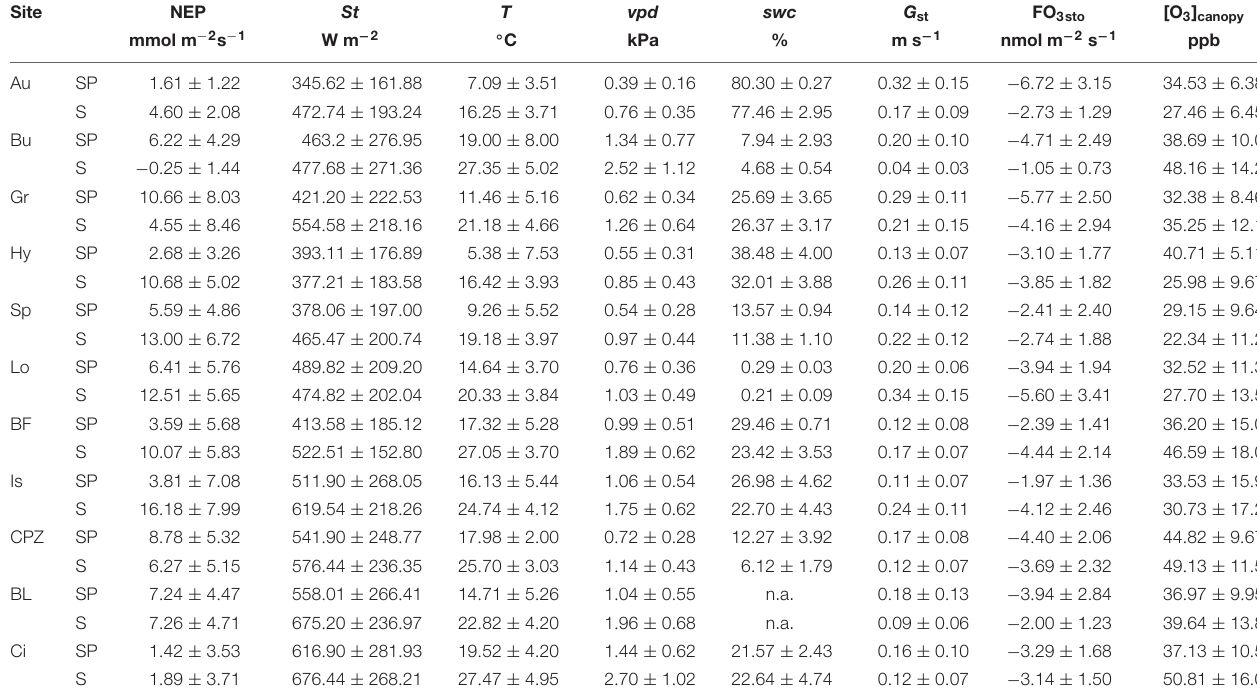
TABLE 2 | Mean ± standard deviation of the data recorded during daytime (10:00 – 18:00) of Spring and Summer seasons. Site NEP